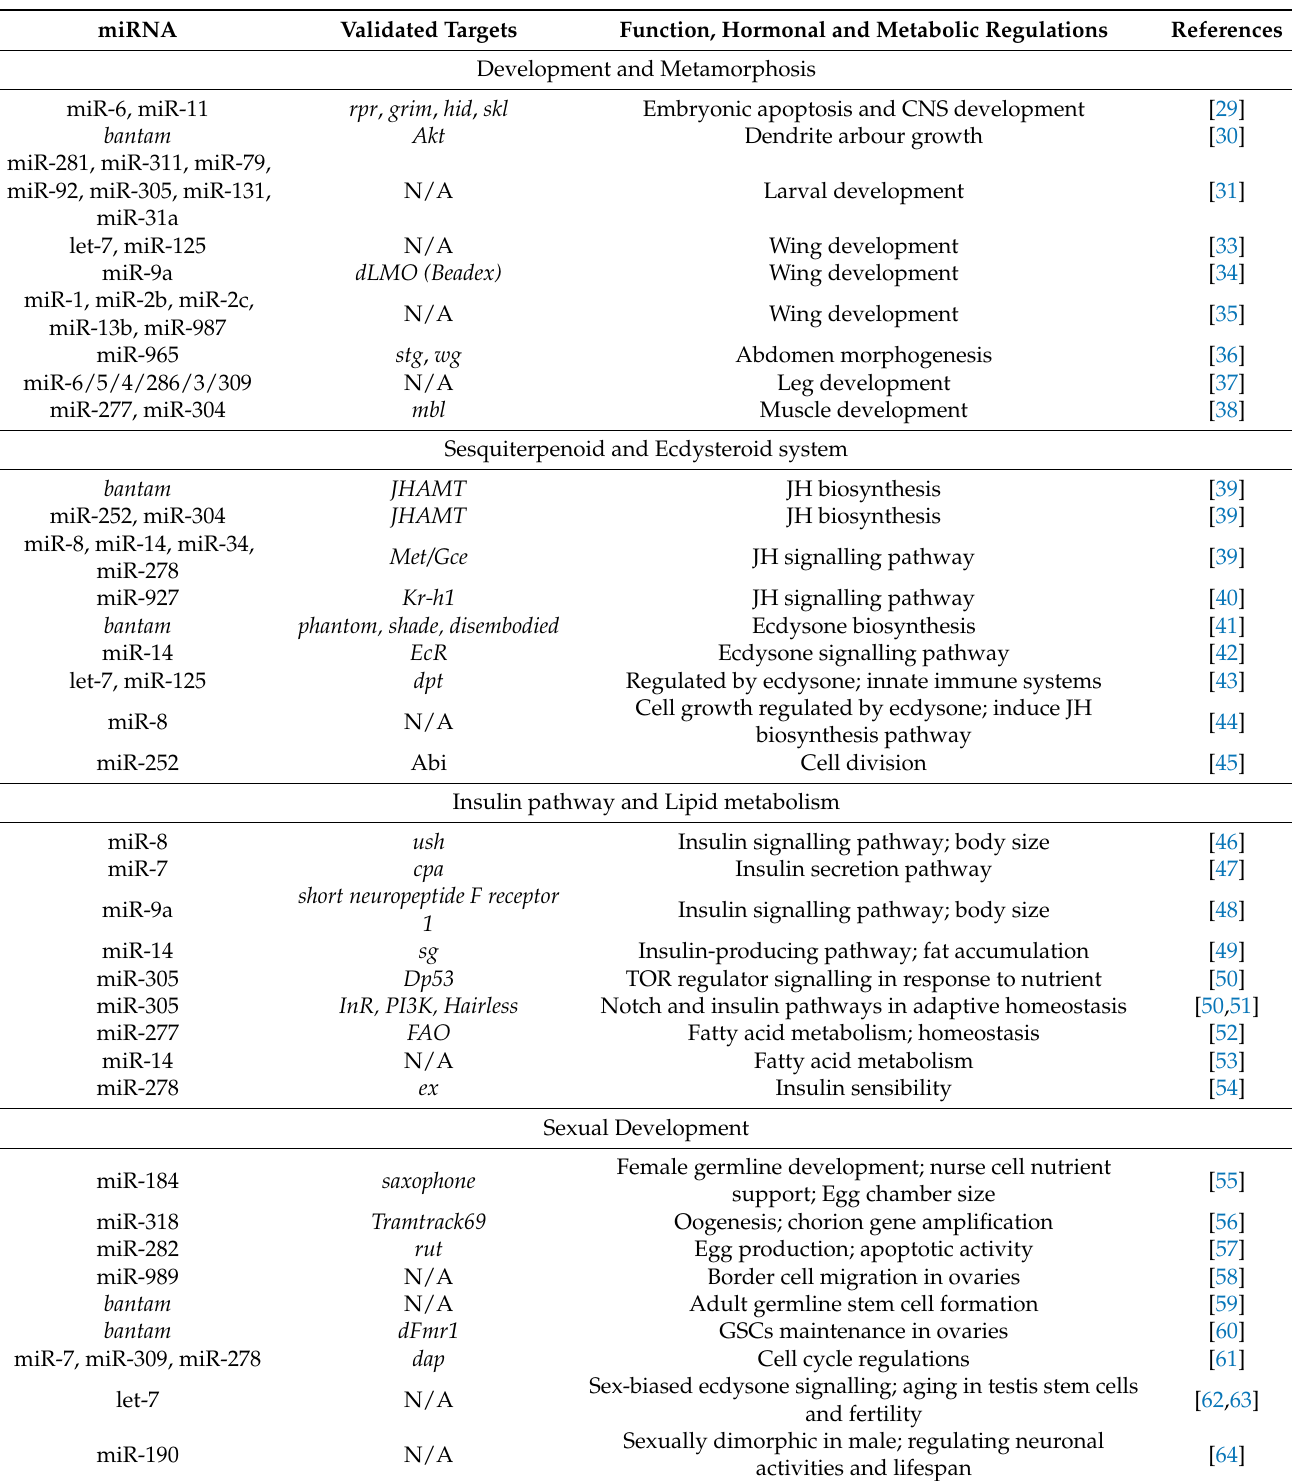
Table 1. Summarisation of miRNAs reported with their validated targets, function, and hormonal and metabolic regulations according to their